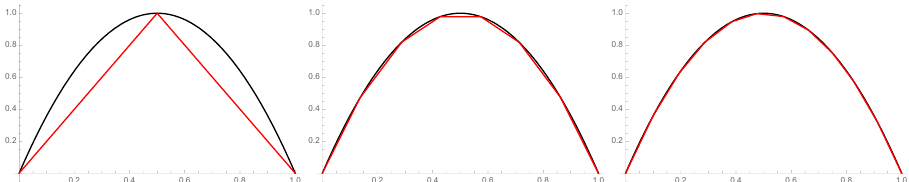
Figure 3. The graphs of the original function f 1 (the black line) and its piecewise linearizations l f (the red line), where ‘ = 3,8,12.